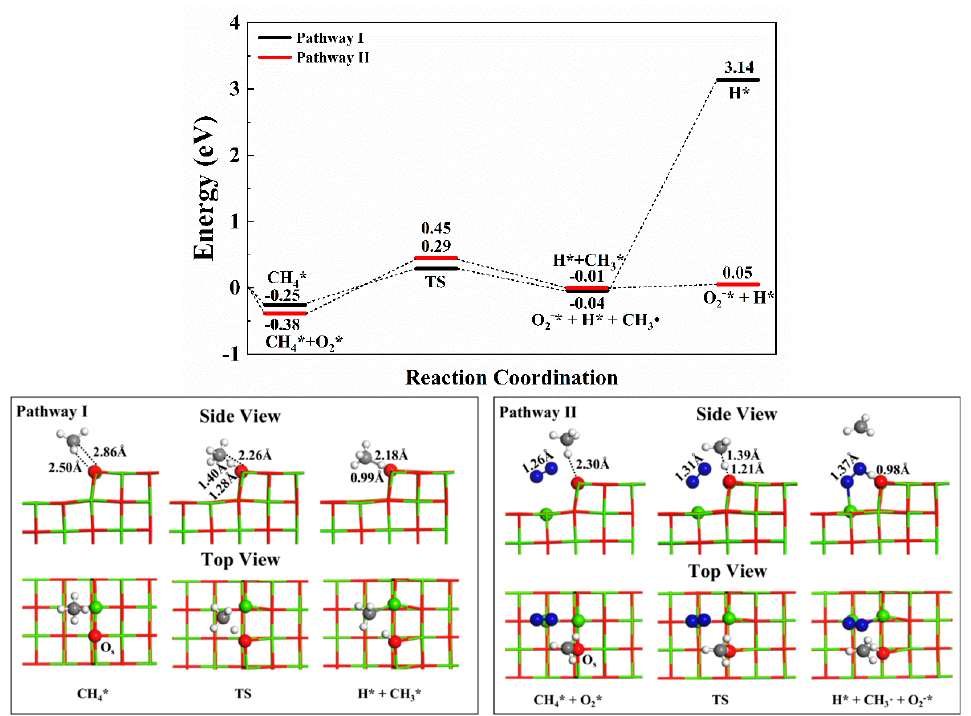
Figure 2. The reaction pathway of CH 3 radical generation and key configurations along reaction pathway. “*” indicated the surface adsorbed spices.